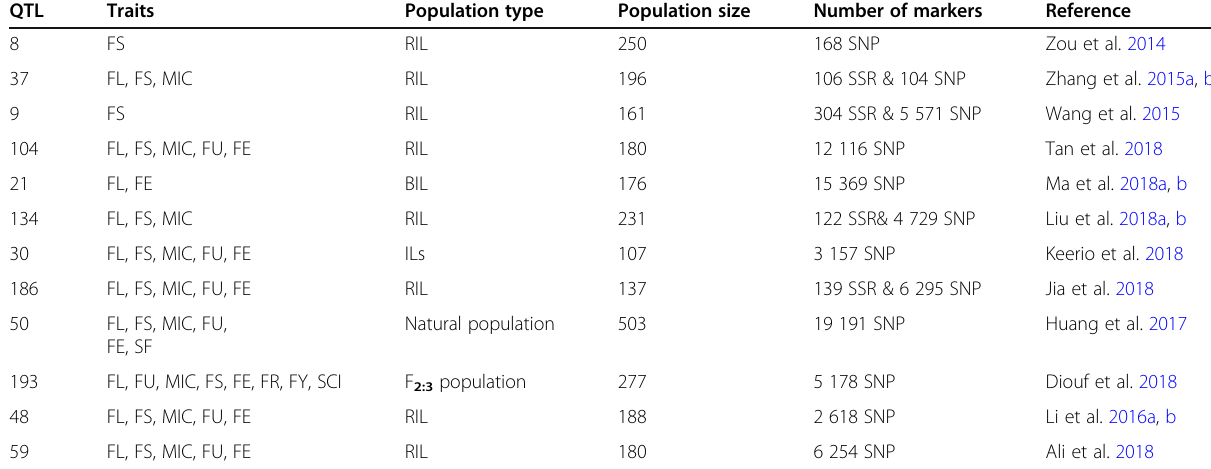
Table 1 Fiber quality traits QTLs mapped by SNP markers from 12 papers